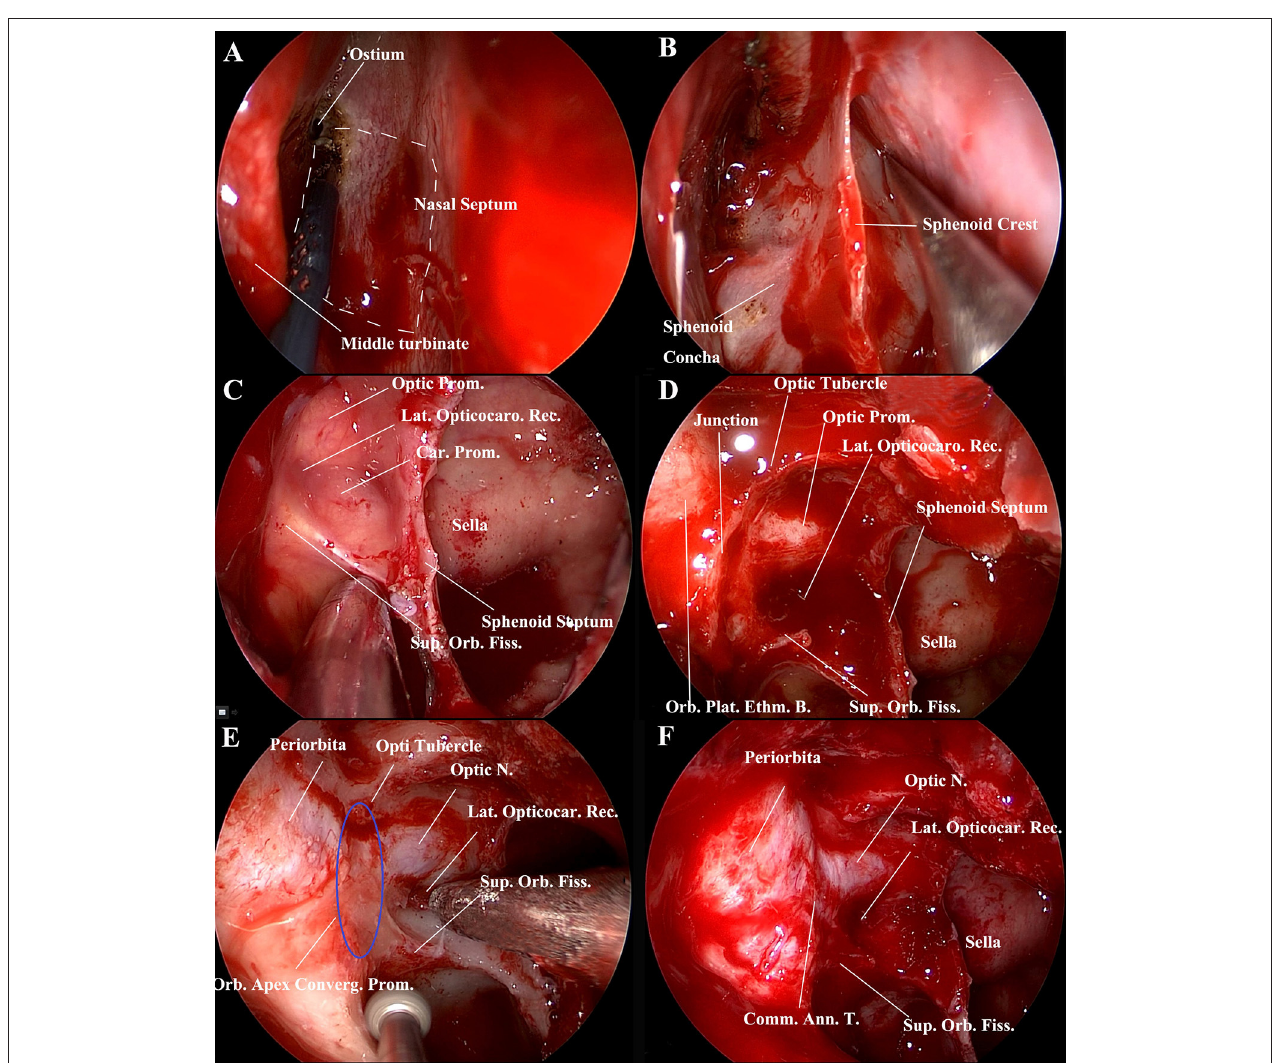
FIGURE 3 | Endoscopic endonasal procedure for decompression of the orbital apex, including the medial walls of the optic canal the superior orbital fissure, and the orbital apex convergence portion (proper orbital apex) (right side). (A) The nasal cavity was decongested with cotton pledgets soaked in 1:10,000 adrenaline, and landmarks, namely, the middle turbinate, superior turbinate, and ostium of the sphenoid sinus, were identified. A free mini posterior nasoseptal flap (white dotted lines) was harvested for reconstruction. (B) Posterior nasal septostomy and anterior sphenoidal wall resection. The contralateral mucosa of the anterior face of the sphenoid sinus was incised for a binostril approach. (C) The wide opening of the anterior face of the sphenoid facilitates access by the endoscope and up to three instruments simultaneously. Panoramic visualization of surgical landmarks aided orientation during the surgical procedure. Landmarks of the lateral wall of the sphenoid sinus included the optic prominence, the opticocarotid recess, and the superior orbital fissure prominence. (D) Endoscopic endonasal view of the medial wall of the orbital apex, namely, the optic prominence, the superior orbital fissure prominence, and the orbital apex convergence prominence, with the latter being the junction of the lateral wall of the sphenoid sinus and the orbit plate of the ethmoid bone. (E) Drilling of the bones of the medial wall of the optic canal, superior orbital fissure, and orbital apex convergence prominence. The orbital apex convergence prominence coursed from the optic tubercle superiorly to the junction of the orbital plate of the ethmoid bone and the lateral wall of the sphenoid sinus inferiorly (blue elliptic line). (F) Endoscopic view of the optic nerve (intracanal segment), superior orbital fissure, and orbital apex convergence portion (proper orbital apex). The optic nerve superiorly and the superior orbital fissure inferiorly converge into the convergence portion (proper orbital apex). The contour of these three structures forms a π -shaped configuration after 90-degree rotation. The optic sheath, the periosteum of the superior orbital fissure, and the periorbita of the orbital apex were intact. Ann., Annual; B., Bone; Car., Carotid; Com., Common; Converg., Convergence; Ethm., ethmoidal; Fiss., Fissure; Lat., Lateralis; Orb., Orbital; Plat., plate; Prom., Prominence; Rec., Recess; Sphen., Sphenoid; Sup., Superior; T.,